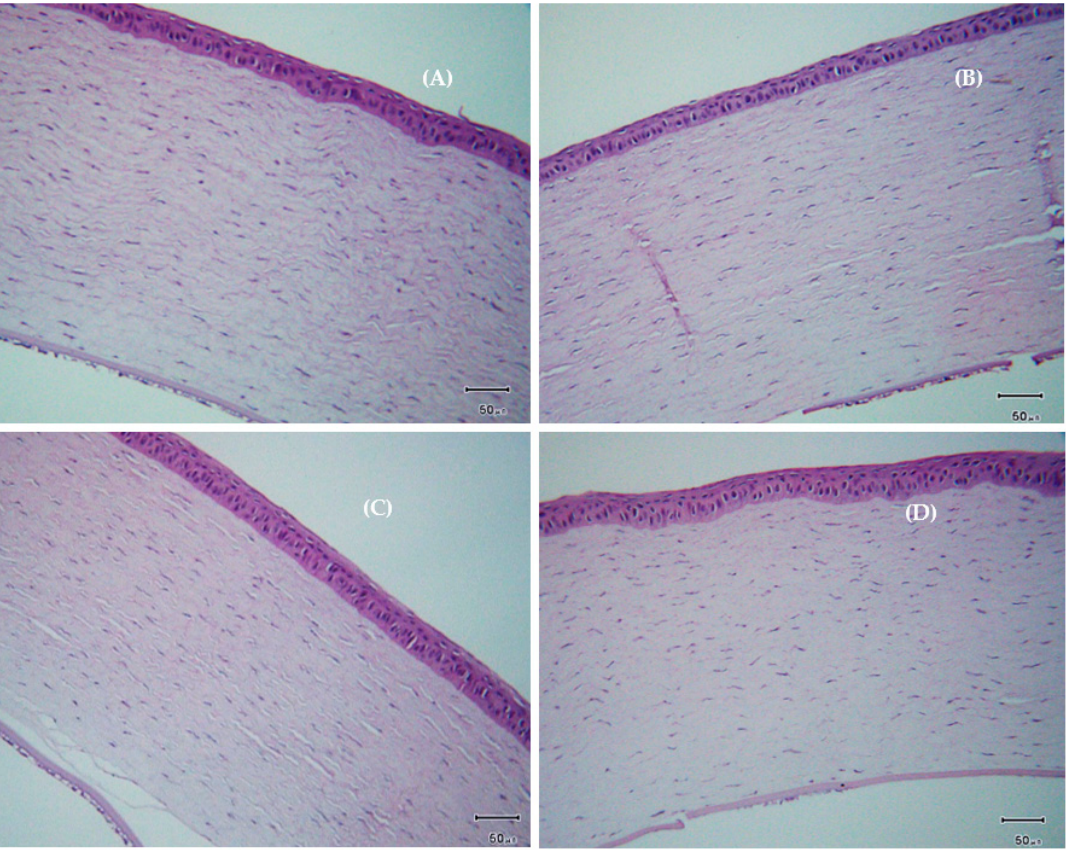
Figure 11. Histological section of cornea with H&E staining acquired from ( A ) control; ( B ) benzalkonium chloride (BAC); ( C ) only AT and ( D ) BSP + AT treated groups, scale bar: 50 µ